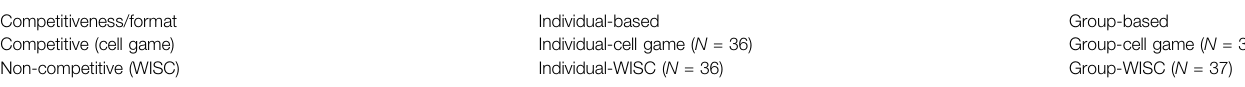
TABLE 1 | The 2 × 2 factorial design on the competitiveness and format of game-based learning.